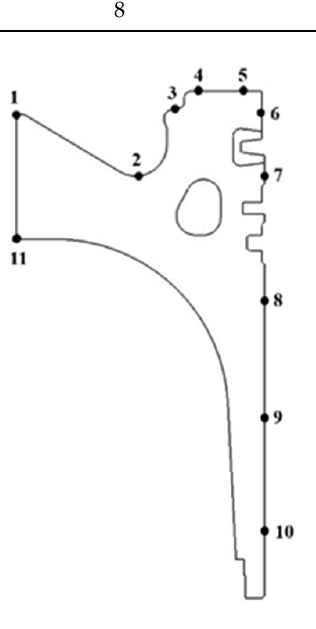
Figure 9. The simplified model with the 11 MPs. Table 5. The average values of the 11 MPs.